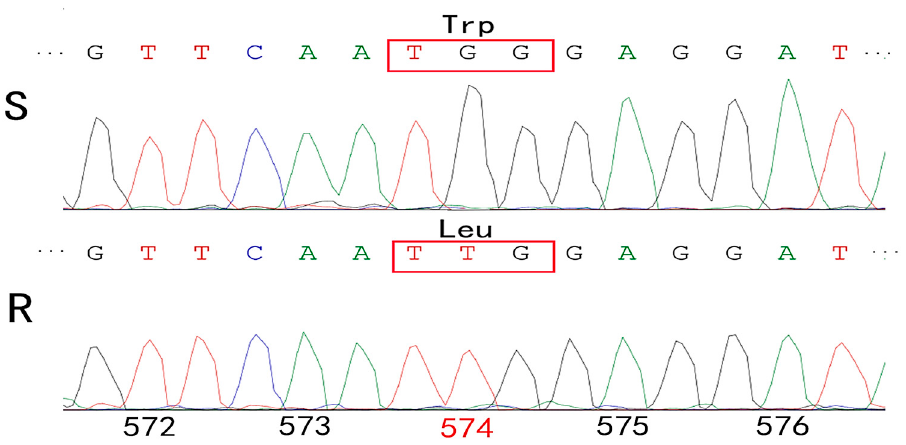
Figure 3. Partial ALS gene sequencing results showing a Trp-574-Leu mutation resulting from a TGG to TTG change in the R population. The amino acid position of ALS was based on Arabidopsis .